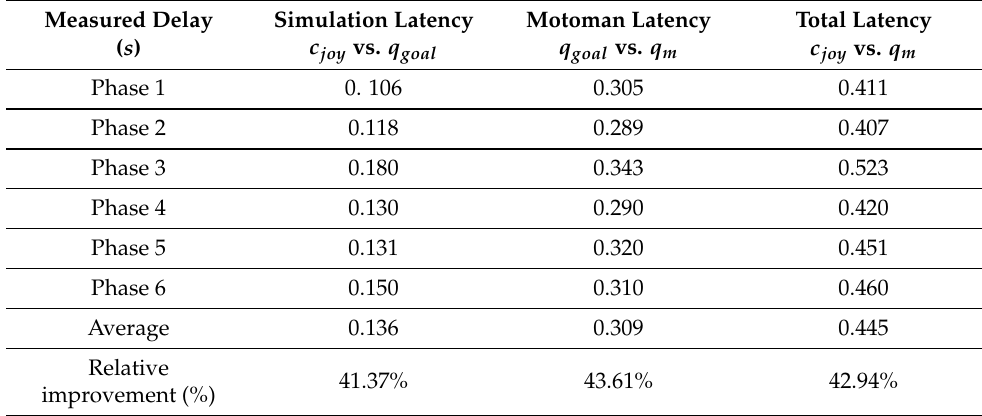
Figure 7. ( a ) First axis displacement while using the improved Motoman ROS node for teleoperation ( b ) Zoom on phase 2 ( c ) Zoom on phase 3. Table 2. Average measured latency while using improved control